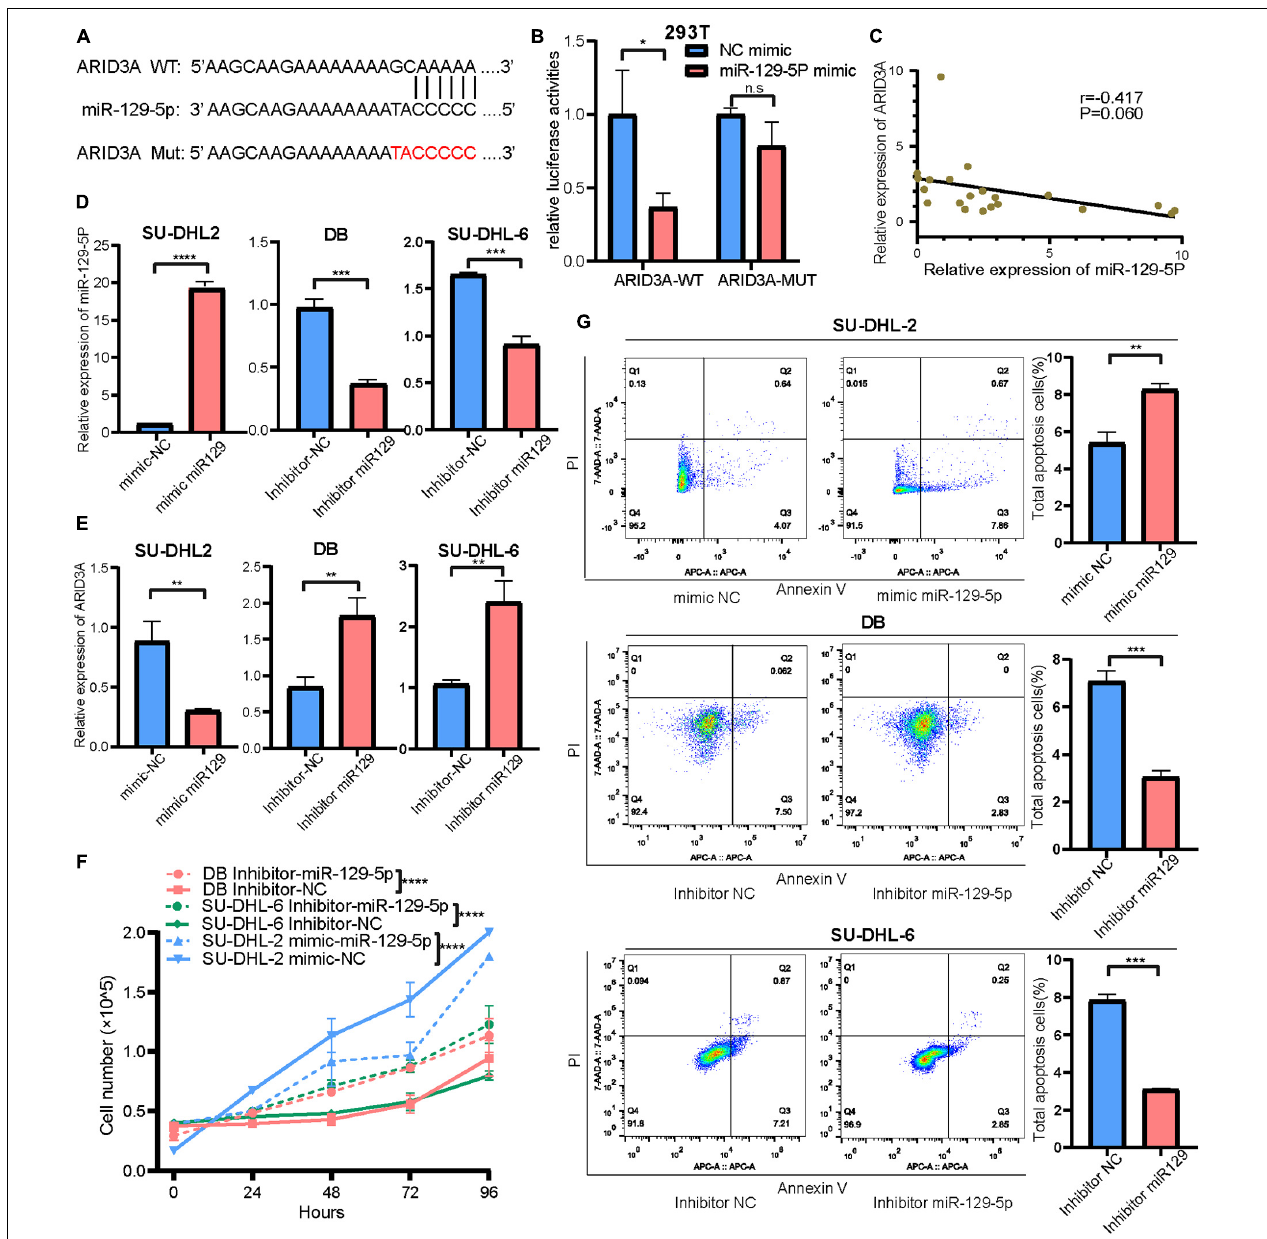
FIGURE 3 | (A) Interaction sequences of ARID3A for miR-129-5p binding were acquired from Starbase v3.0 and mutated by altering them with complementary sequences. (B) Dual-luciferase reporter gene assays were performed to detect the interaction between ARID3A and miR-129-5p. (C) Pearson’s correlation curve showing that ARID3A was negatively correlated with miR-129-5p in DLBCL peripheral blood. (D) The inhibition and overexpression of miR-129-5p in DLBCL cells was confirmed with RT-qPCR assays. (E) RT-qPCR showing the expression of ARID3A in miR-129-5p-overexpressing SU-DHL-2 cells and miR-129-5p -knockdown DB and SU-DHL-6 cells. (F) Cell proliferation ability of transfected cells. Cells were placed in 24-well plates and counted after 0, 24, 72, and 96 h and the cell number were determined with trypan blue exclusion staining. (G) Cell apoptosis of SU-DHL-2 with mimic miR-129-5p, DB and SU-DHL-6 with inhibitor miR-129-5p, and negative control cells was measured through flow cytometry analysis. All data represented mean ± SD from three independent experiments. * P < 0.05; ** P < 0.01; *** P < 0.001; **** P < 0.0001.